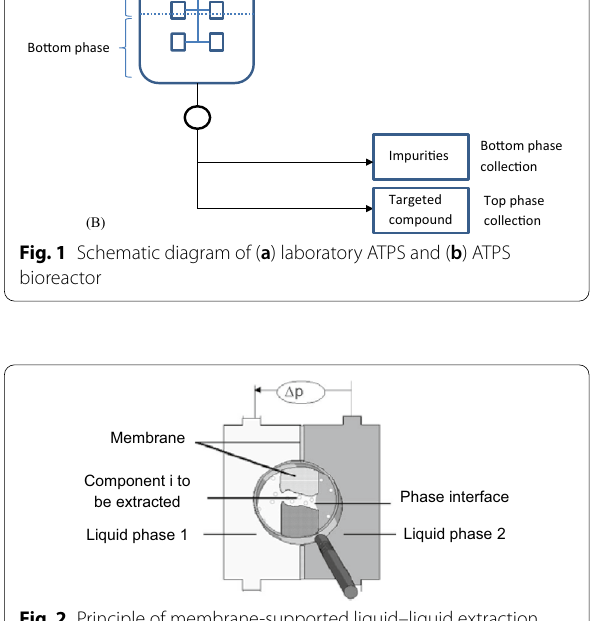
Fig. 2 Principle of membrane-supported liquid–liquid extraction (MEMEX) as explained by [123]. ΔP (Delta P) is a mathematical term symbolizing a change (Δ) in pressure